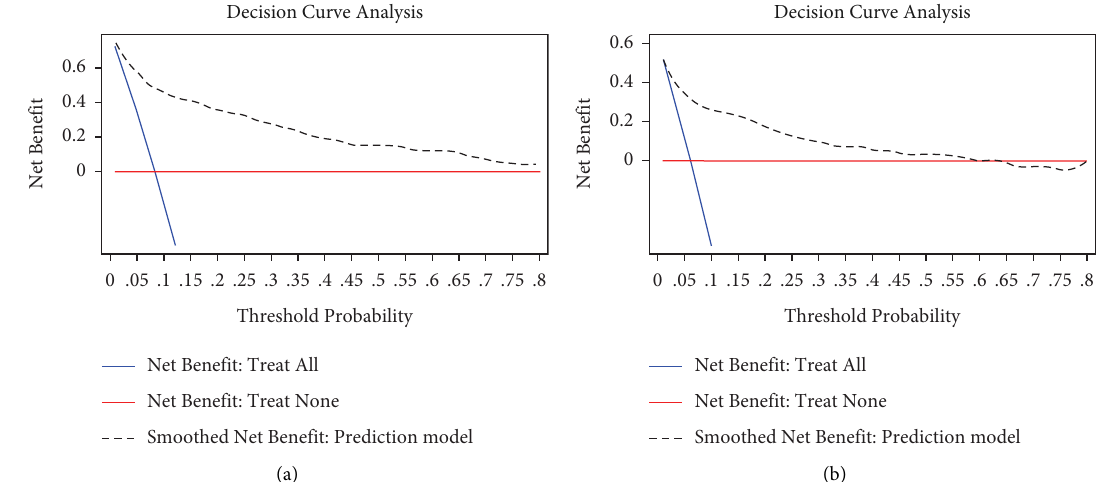
Figure 3: Te decision curve analysis (DCA) for the model predicting probability of NOAF in ACS patients. (a) DCA for the model in the training cohort; (b) the DCA for the model in the validation cohort. Te decision curve of the prediction model is composed of an X -axis which represents continuum of potential thresholds for NOAF risk and a Y -axis which represents the net beneft which is obtained by dividing the net true positives by the sample size. Te blue curve “net beneft: treat all” shows the net beneft if all ACS patients were intervened for NOAF. Te red line “net beneft: treat none” shows the net beneft if no ACS patients were intervened for NOAF. Te black dotted line “prediction model” curve shows the net beneft if it is used to select patients for NOAF intervention. For example, if the personal threshold probability of a patient was 40%, the net beneft would be 0.2 when using the prediction model to decide whether to intervene NOAF, which means that there are 20 net detected NOAF per 100 patients.